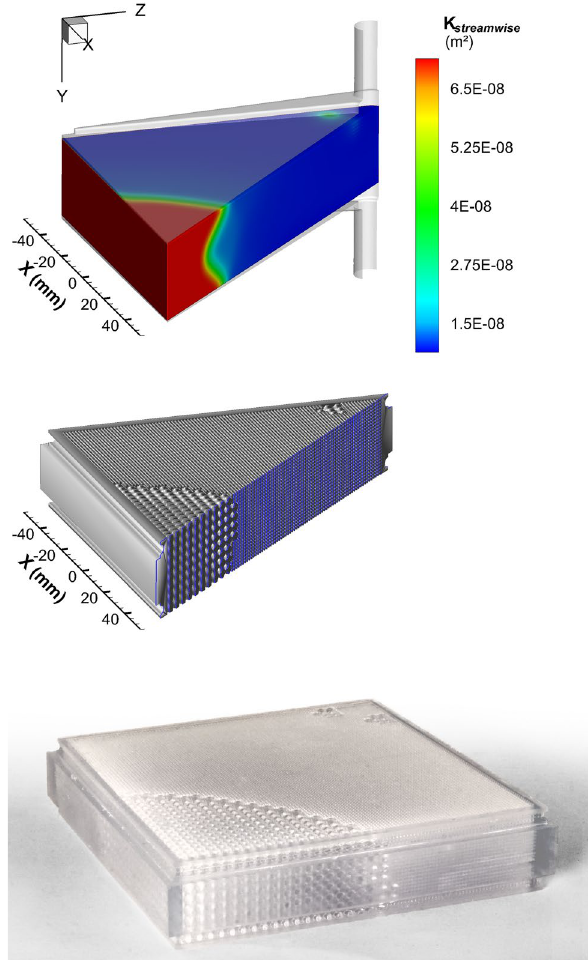
Figure 3. Concretization steps of the TPMS-based membrane module with locally modified permeabilities. ( a ) Simulated permeability field, ( b ) STL prototype after translation of the permeability into Schwarz-P (SWP) TPMS elements including the additional frame, ( c ) 3D printed membrane module. Flow direction in all images is in positive